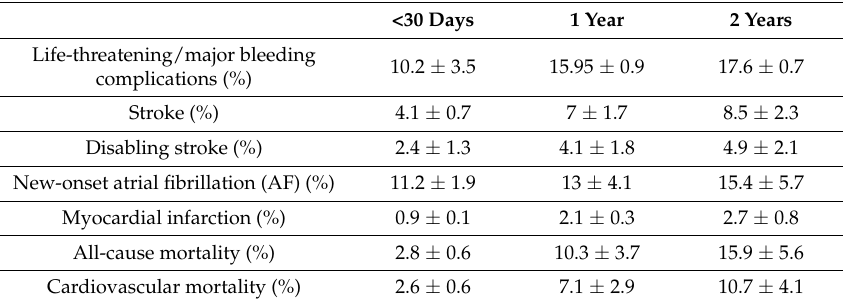
Table 1. Ischaemic and bleeding complications in post-transcatheter aortic valve implantation (TAVI) patients